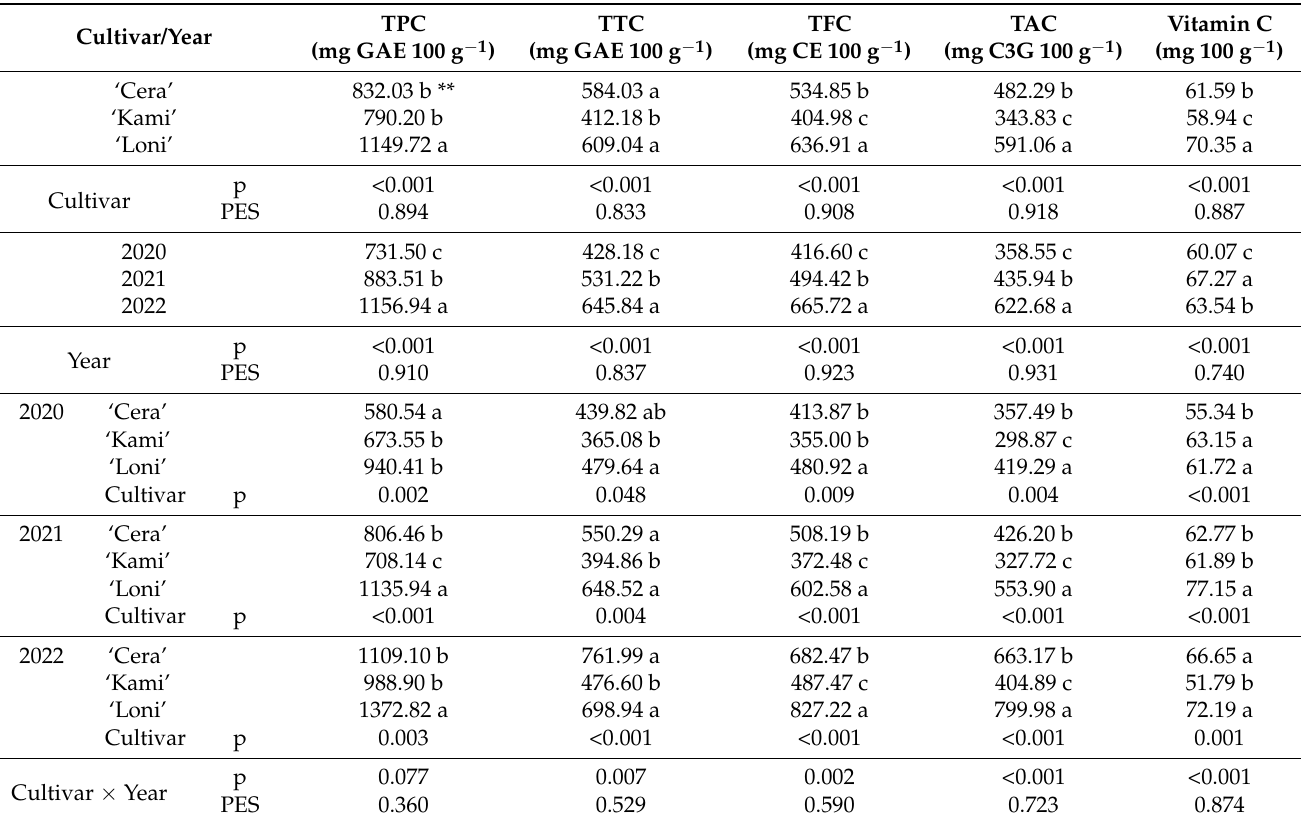
Table 4. Cultivar and year effects on honeyberry total phenolic (TPC), tannin (TTC), flavonoid (TFC), monomeric anthocyanin (TAC), and vitamin C contents